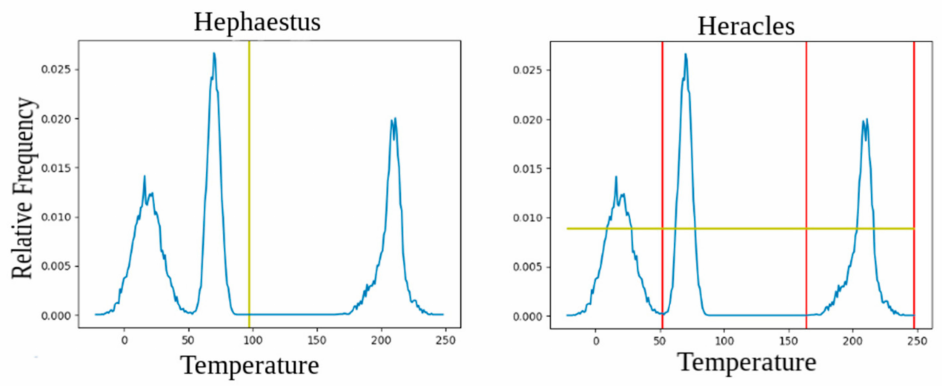
Figure 5. Comparing Heracles’ and Hephaestus’ phenomena